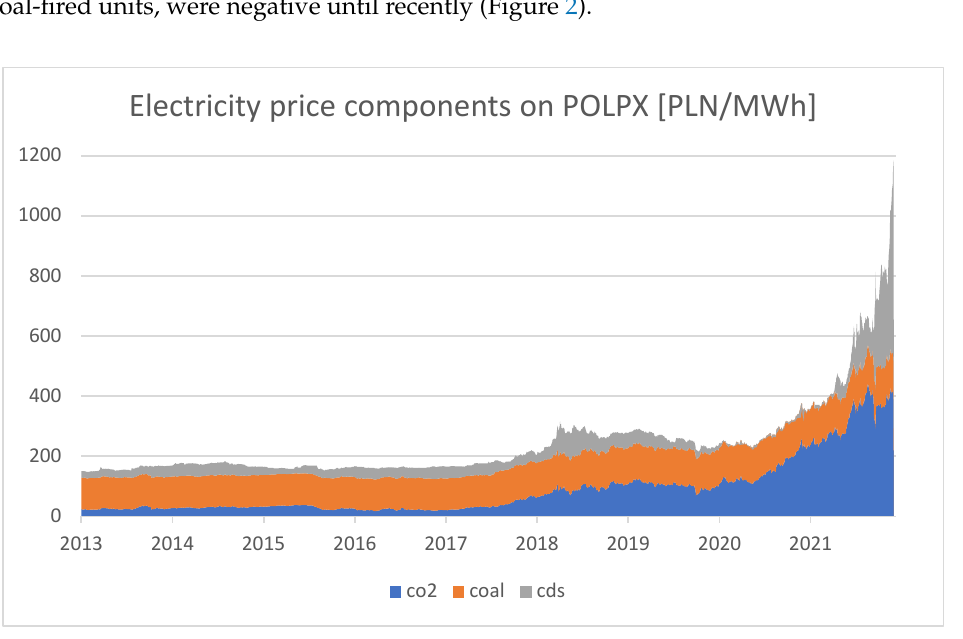
Figure 2. Components of energy prices in Poland (source: created by the authors in 2022).